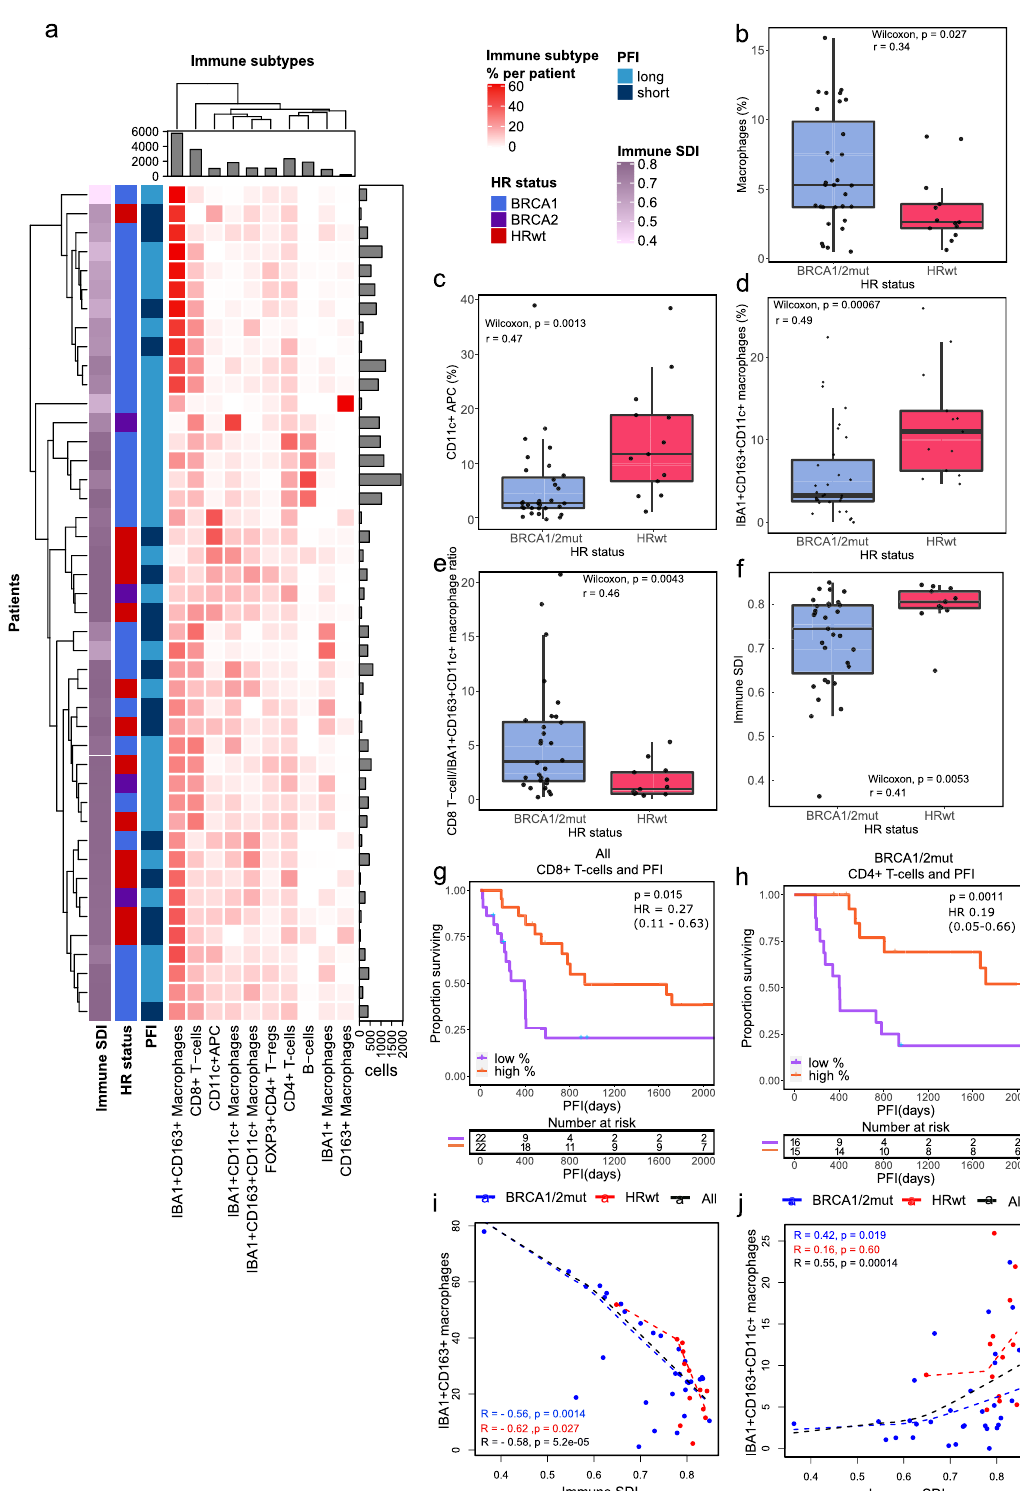
Functional marker expressions for the immune cell subtypes are presented in Supplementary Fig. 2v.